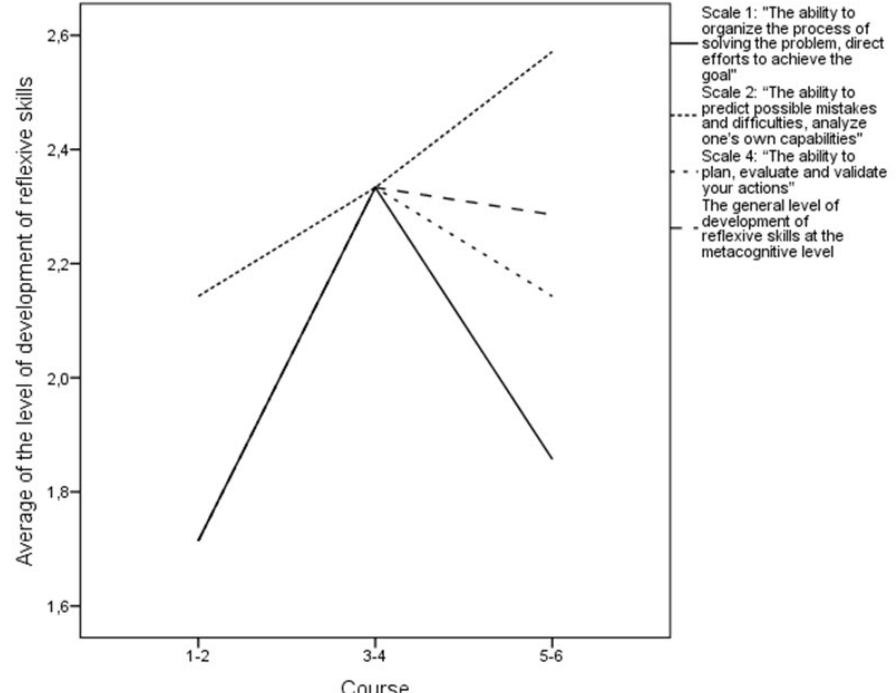
Figure 2. The results of the method “The reflexive skills (metacognitive level)” (O. V. Savchenko) among students in accordance with the curriculum study with the use of one-factor dispersion analysis of variance